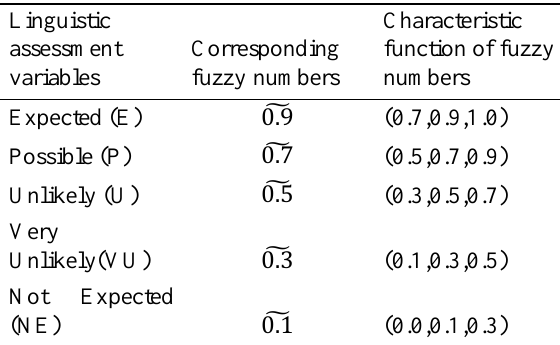
Table 1. Linguistic expressions and their corresponding fuzzy numbers for probabilistic occurrence [43,59].